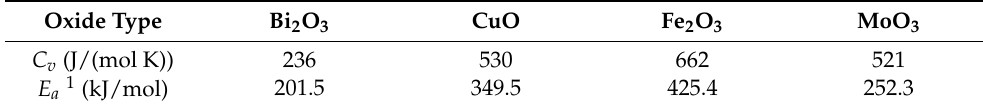
Table 3. Material parameter of oxide